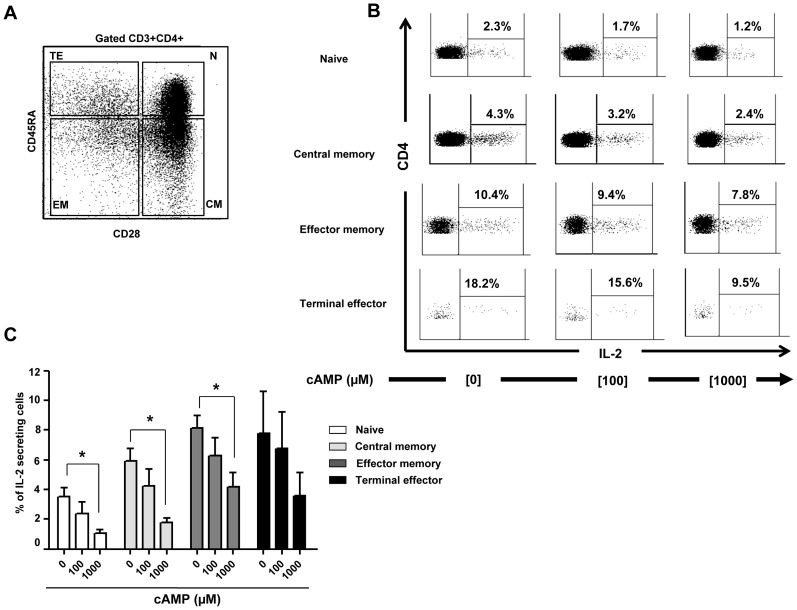
cAMP induced inhibition of IL-2 production by CD4+ T cell subsets.(A) Gating strategy. (B) Inhibition of intracellular IL-2 production by cAMP in all anti-CD3/CD28 (2 µg/ml) stimulated sub-populations of CD4+ T cells (representative figure of 5 experiments). (C) % Inhibition of intra-cellular IL-2 production (pooled data of 5 experiments) by all CD4+ T cells sub-populations. *P<0.05.